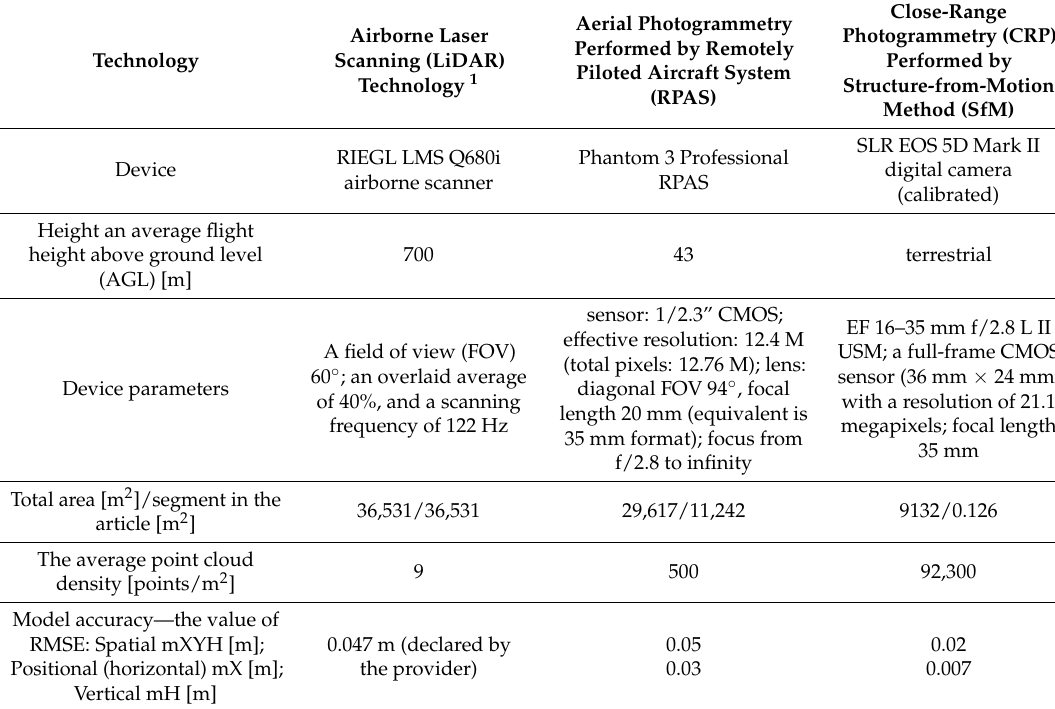
Table 1. Applied technologies in data acquisition during the field